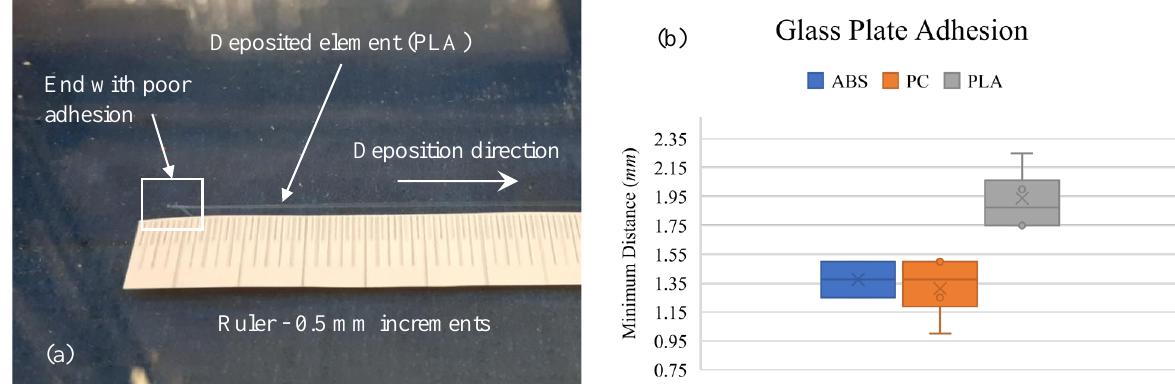
Figure 13. ( a ) Printed element on glass plate (PLA shown) and ( b ) minimum printed distance needed for adhesion to glass plate.